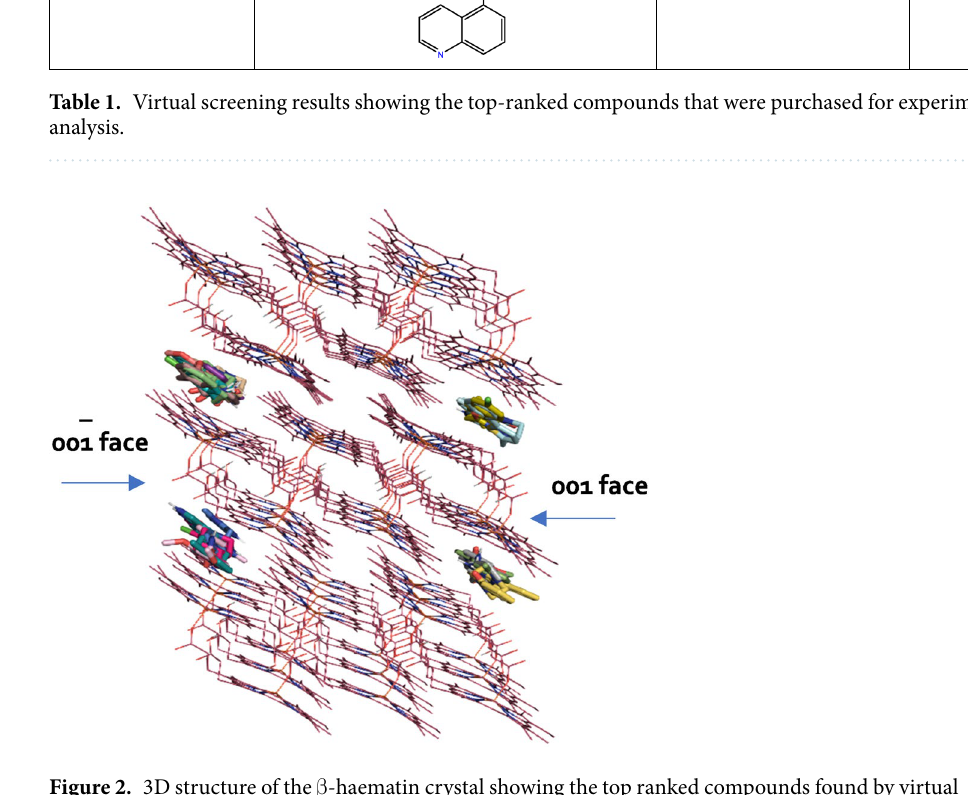
Figure 2. 3D structure of the β -haematin crystal showing the top ranked compounds found by virtual screening exhibiting a preference for docking with the 001 and 00 1